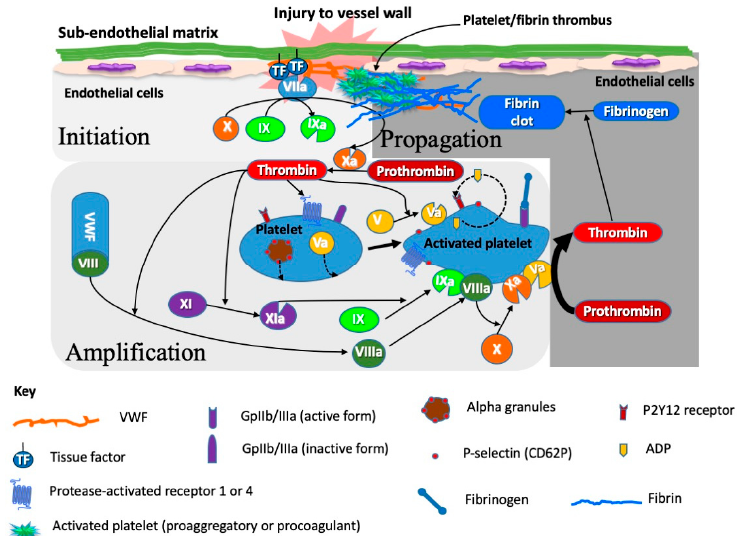
Figure 4. The cell based or platelet-driven model of hemostasis reflects the incorporation of platelets and other components of primary hemostasis (e.g., plasma and platelet derived VWF) and the secondary elements of hemostasis (i.e., clotting factors) to provide a composite hemostasis process. Platelets provide both the building blocks to the formation of the platelet plug (or thrombus) as well as the assembly point for secondary hemostasis pathways. Platelets contain various granules which release their cargo upon platelet activation; this cargo comprises procoagulant material such as factor V, fibrinogen, and